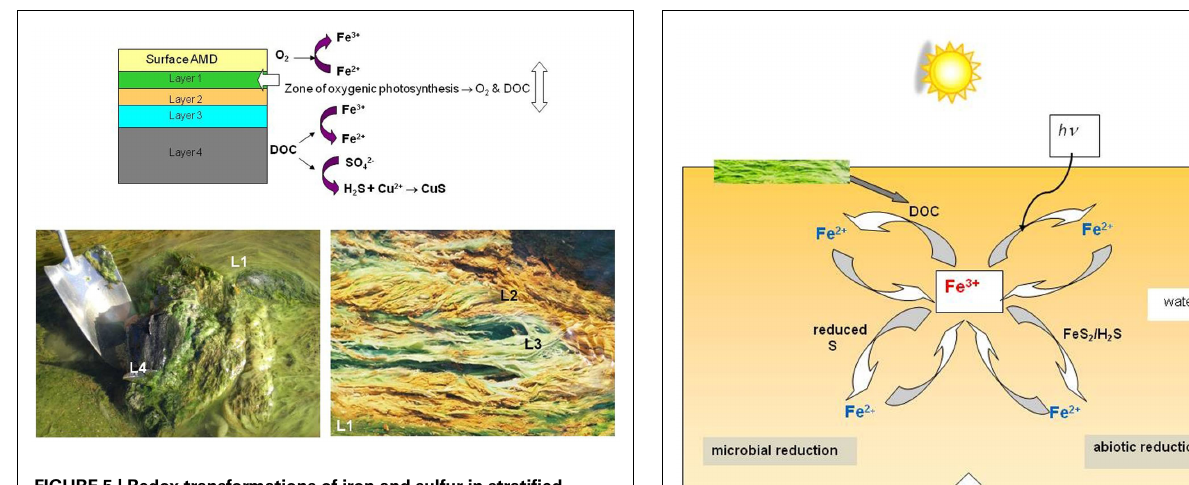
FIGURE 5 | Redox transformations of iron and sulfur in stratified streamer/mat growths found in a channel draining ad abandoned copper mine (Cantareras, Spain). The differently colored streamer/mat layers are indicated in the top diagram, and shown (as L1, L2 etc.) in the lower photographs.